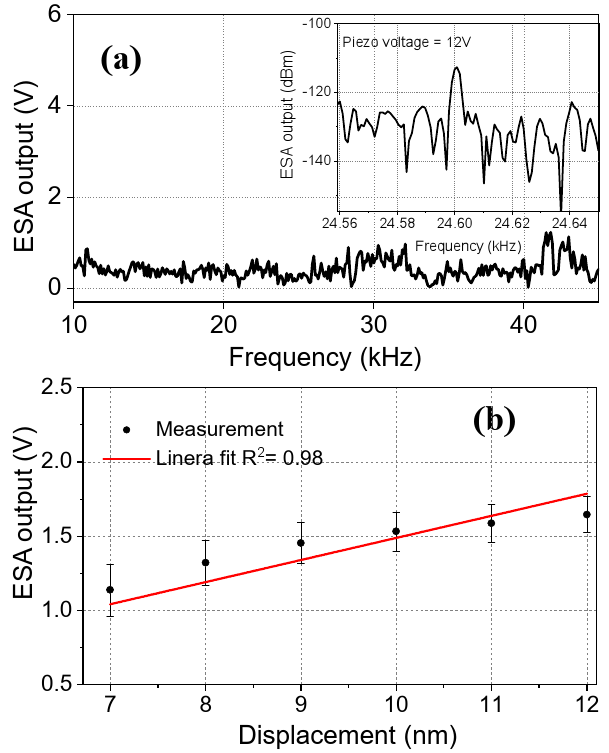
Figure 6. ( a ) The frequency spectrum of the regular fiber with a tip diameter of d t = 125 µm. No resonance was observed. The ESA output response at f = 24.6 kHz for the piezo voltage of 12 V is shown in the inset. ( b ) The ESA output versus displacement values at f = 24.6 kHz. The red line indicates the linear fit.